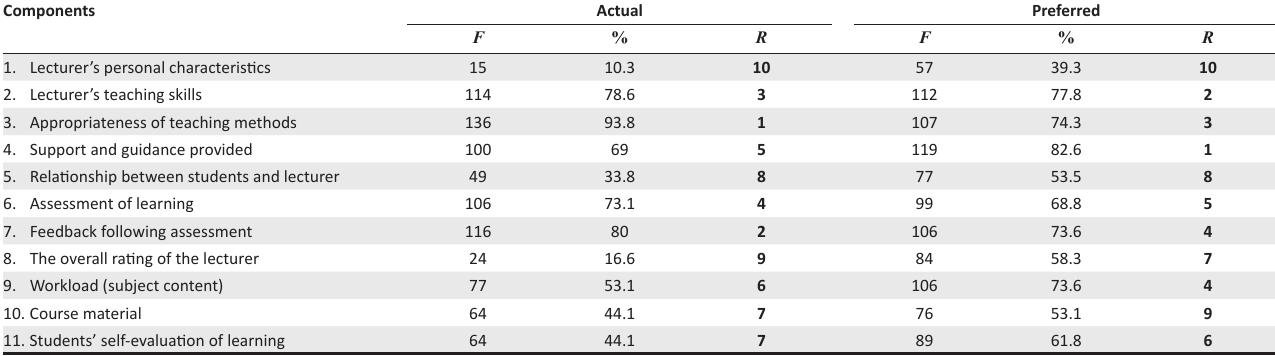
TABLE 3: Components of the evaluation tool.